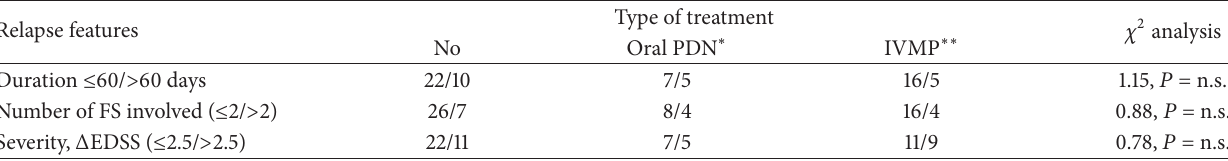
Table 2: Treatment allocation according to relapse features.